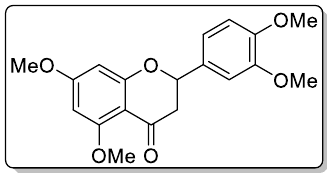
Figure 9. This is chemical formula of the compound 3 (Figure 4). Compound 4 —5,7-dihydroxy-2-(4-hydroxy-3-(2- (4-hydroxyphenyl)-4-oxo-4H-chromen- 6-yl) phenyl)-4H-chromen-4-one (Figure 10), 45 mg of the compound was isolated: the yield was